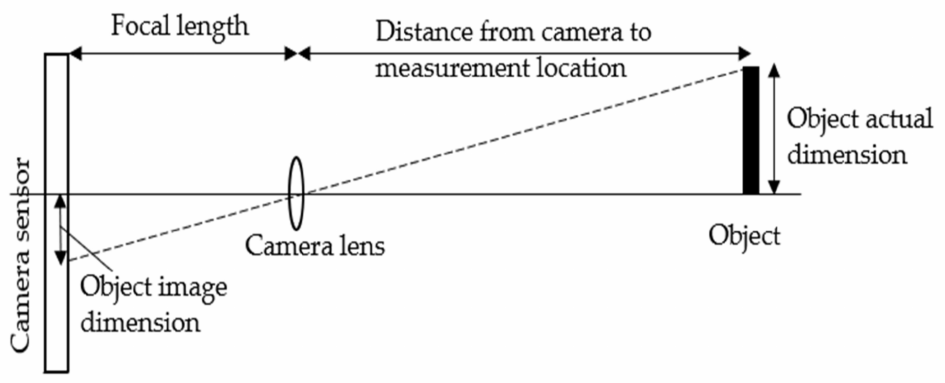
Figure 9. Camera principle